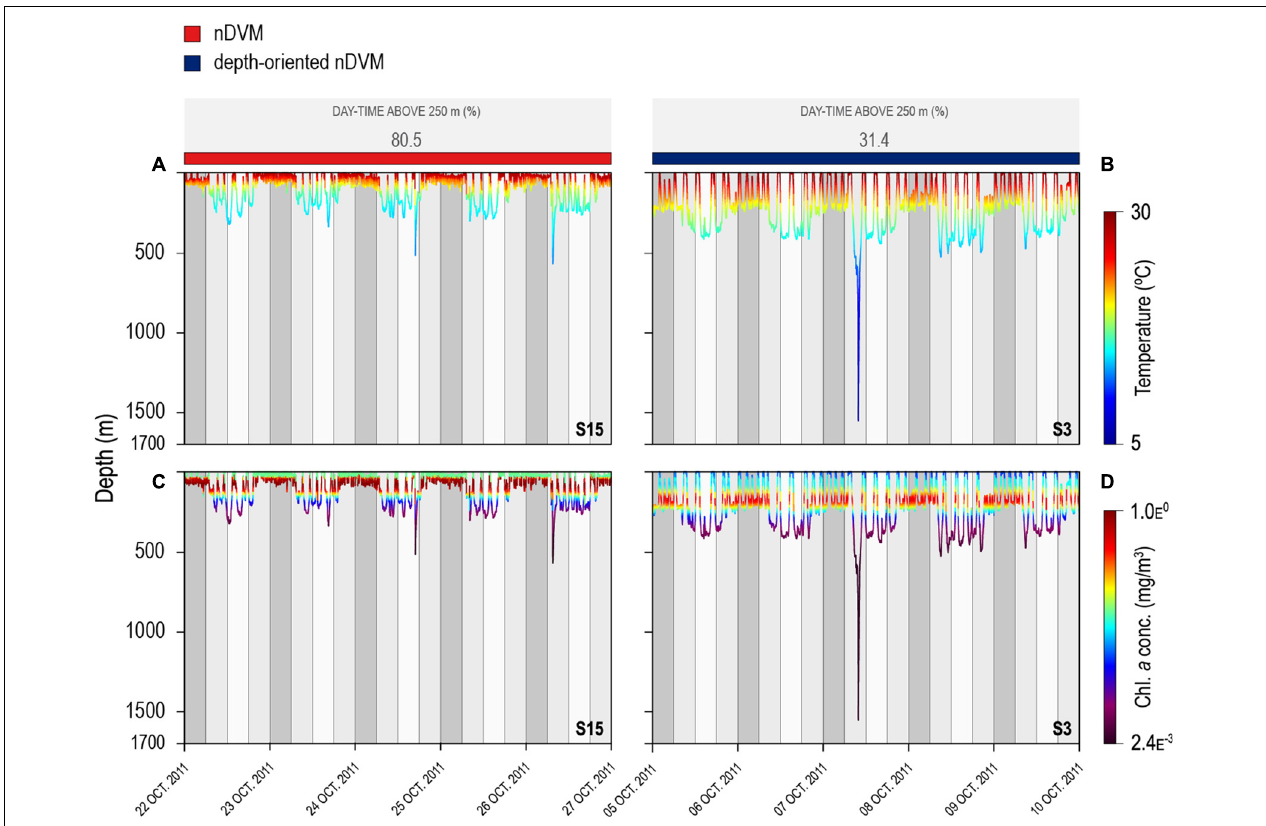
FIGURE 4 | Archival 5-day period depth series for two individual blue sharks, during nDVM for shark #15 on the left (A,C) and depth-oriented nDVM for shark #3 on the right (B,D) . Shark depth is overlaid with water temperature (A,B) and chlorophyll a concentration (C,D) . Coloured bar above represent the identified diel